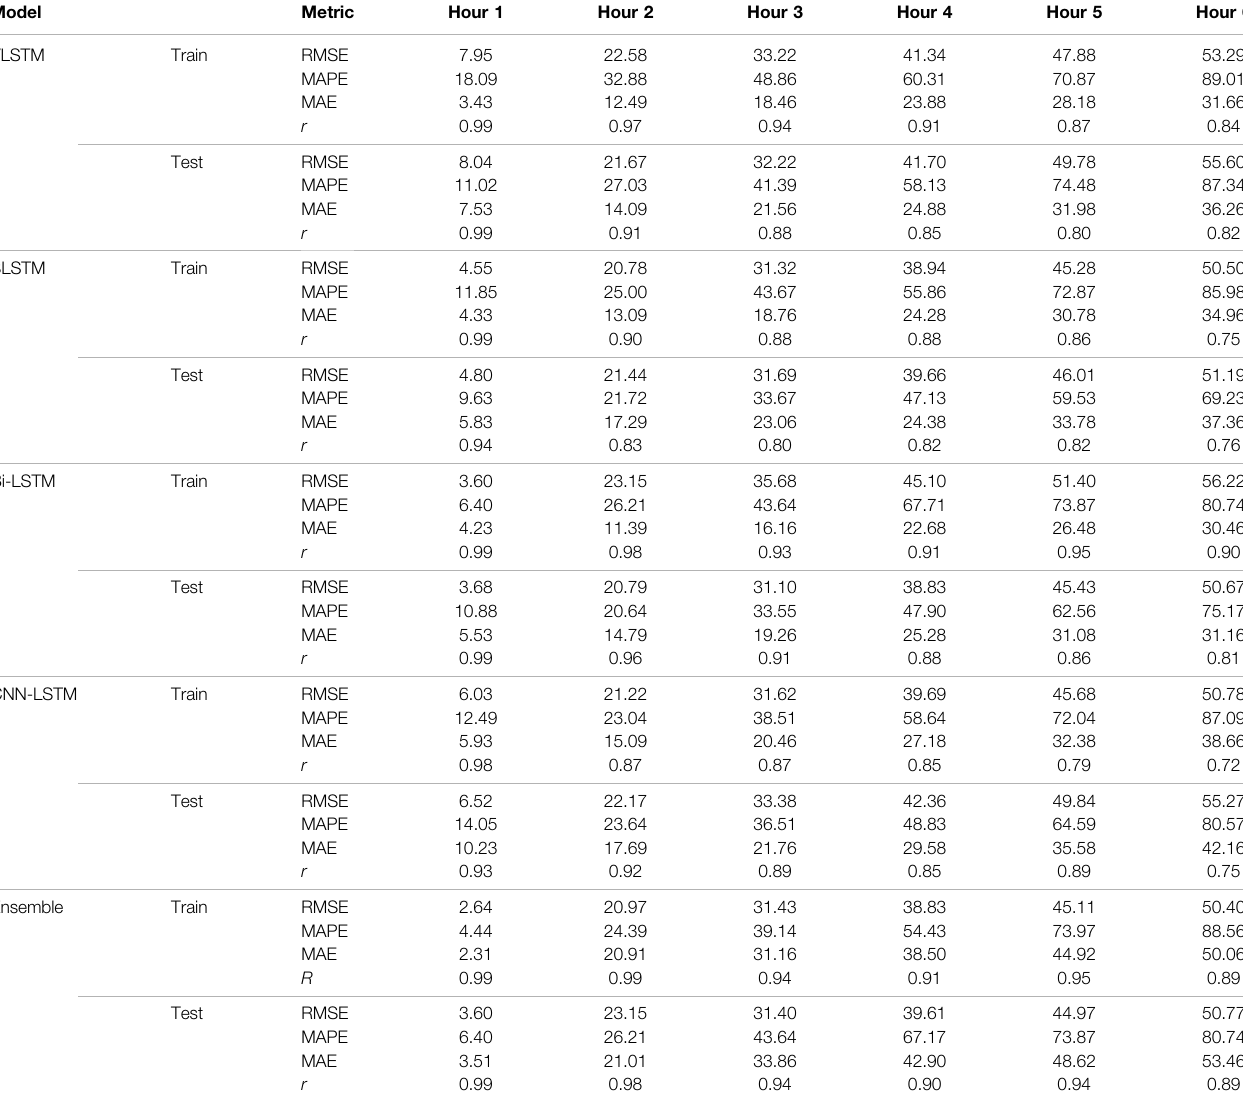
between two sets of data. The range of r-value is between − 1 and 1, where positive values represent positive linear relationships and negative values represent inverse linear relationships between the